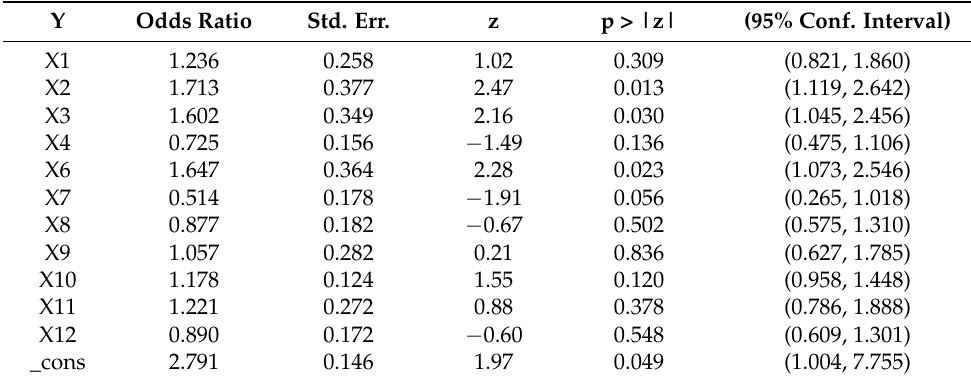
Table A3. The second step of stepwise logistic regression.